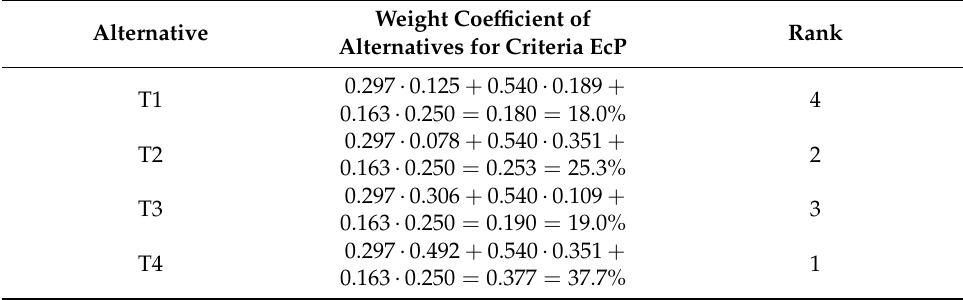
Table 9. Ranking by economic criteria.